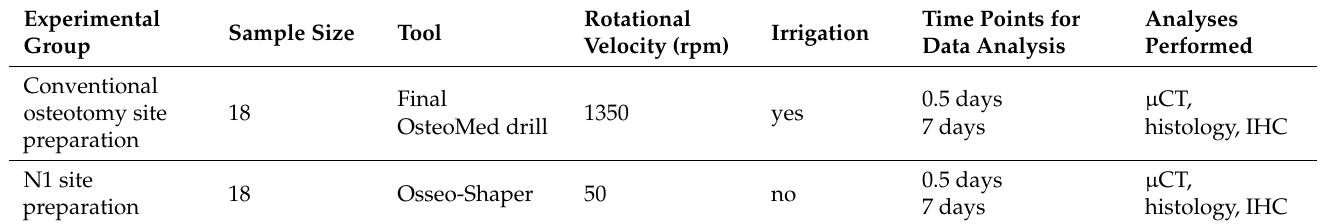
Table 1. Preclinical experimental